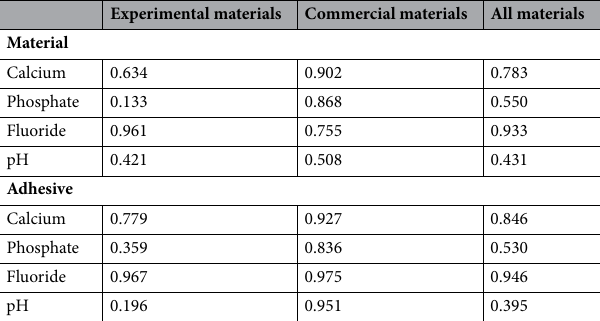
Table 3. Partial eta-squared values as a measure of the effect size for factors “material” and